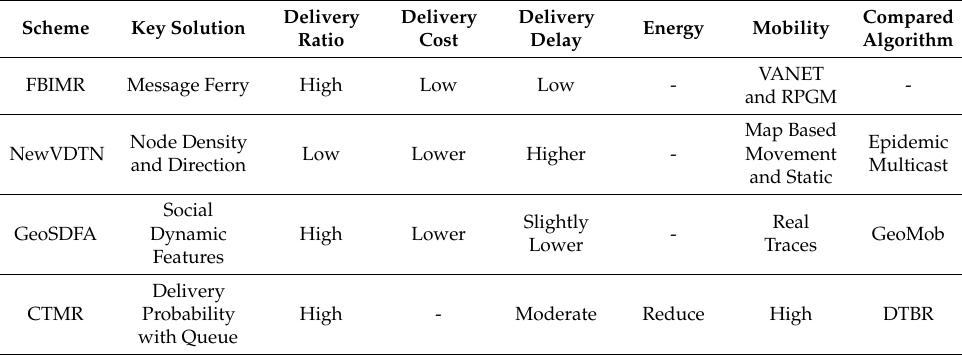
Table 4. Performance comparison of geographical multicast routing in